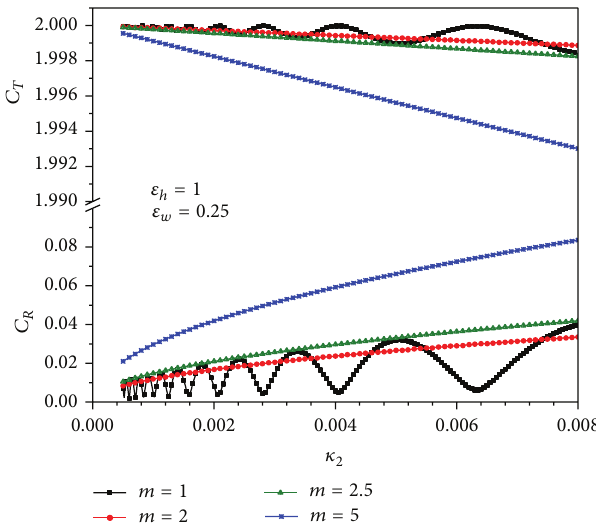
Figure 4: Reflection/transmission coefficients as a function of the kinematical parameter 𝜅 2 with 𝜀 ℎ = 1 and 𝜀 𝑤 = 0 . 25 for four values of 𝑚(= 1 , 2 , 2 . 5 , 5 ) .